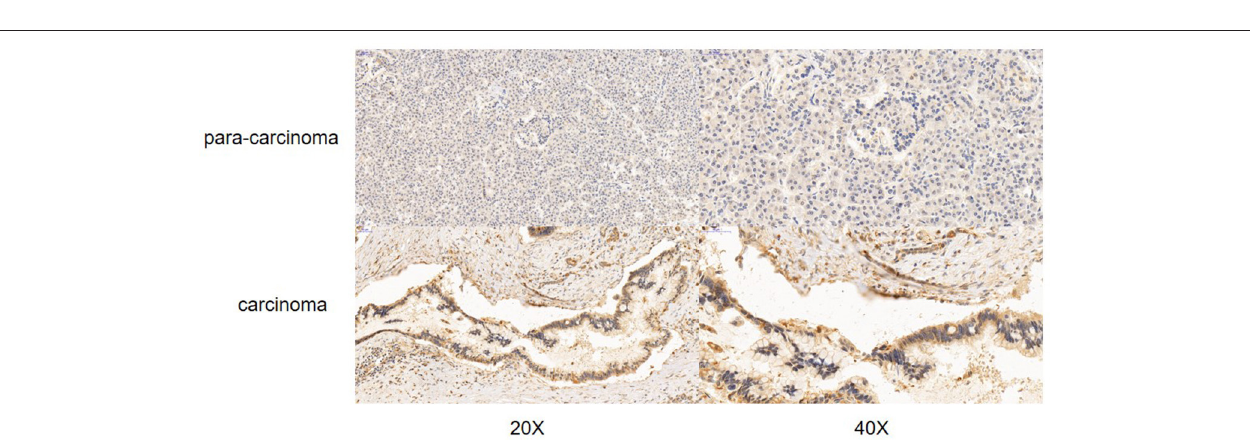
“ UCA1 ” were obtained by applying the LASSO regression dimension reduction analysis. The risk score model was